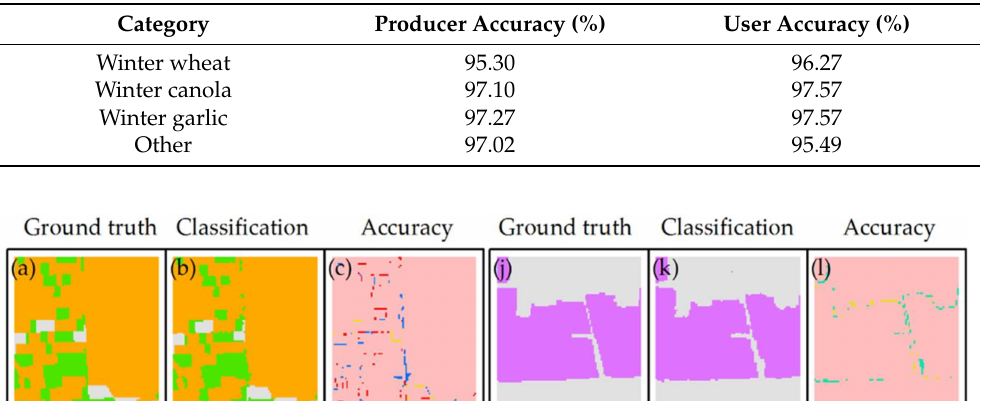
Table 1. Accuracy of classifying different types of winter crops.